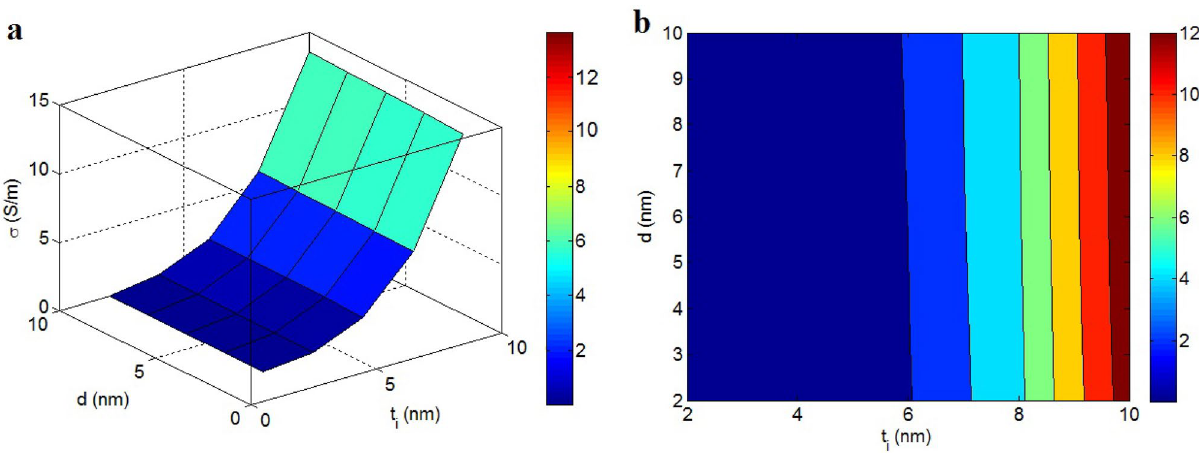
Figure 8. ( a ) 3D and ( b ) 2D designs to express the conductivity at various levels of “t i ” and